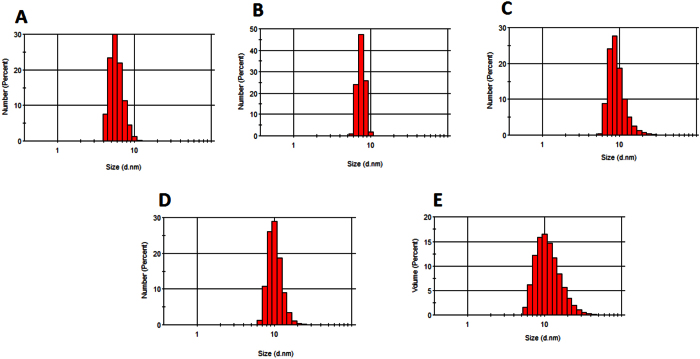
DLS hydrodynamic size curves of the gradient alloyed L-cysteine (A) Cd2.2Zn1.0TeS, (B) Cd2.0Zn1.0TeS, (C) Cd1.8Zn1.0TeS, (D) Cd1.6Zn1.0TeS and (E) Cd1.4.Zn1.0TeS QDs.